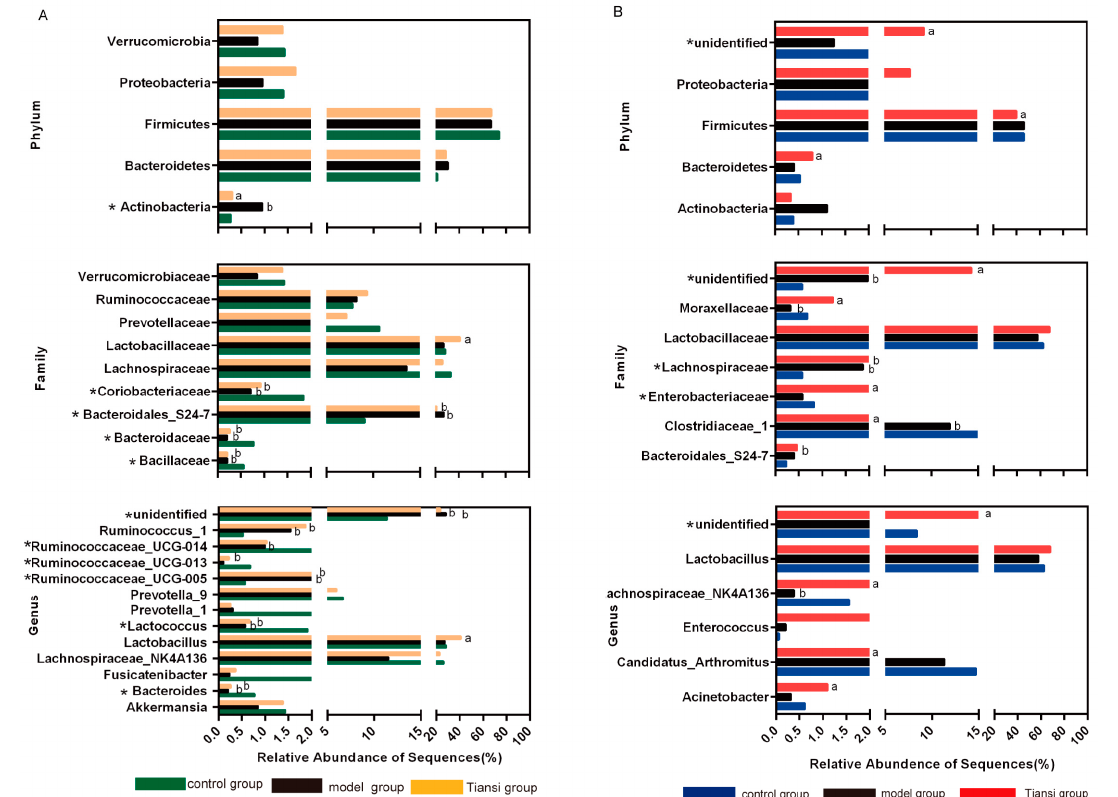
Figure 7. Taxonomic differences in fecal microbiota ( A ) and intestinal mucosa microbiota ( B ) among the control, model and Tiansi-treated groups. There were significant phylum, family and genus-level differences among these groups. A Kruskal–Wallis test identified the most differentially abundant taxa among the groups. * p < 0.05. Metastats was used for multiple comparisons of relative abundance differences of the samples and corrected with an FDR-adjust p -value ≤ 0.1 considered significant a p < 0.1, vs. model group; b p < 0.1, vs. control group.